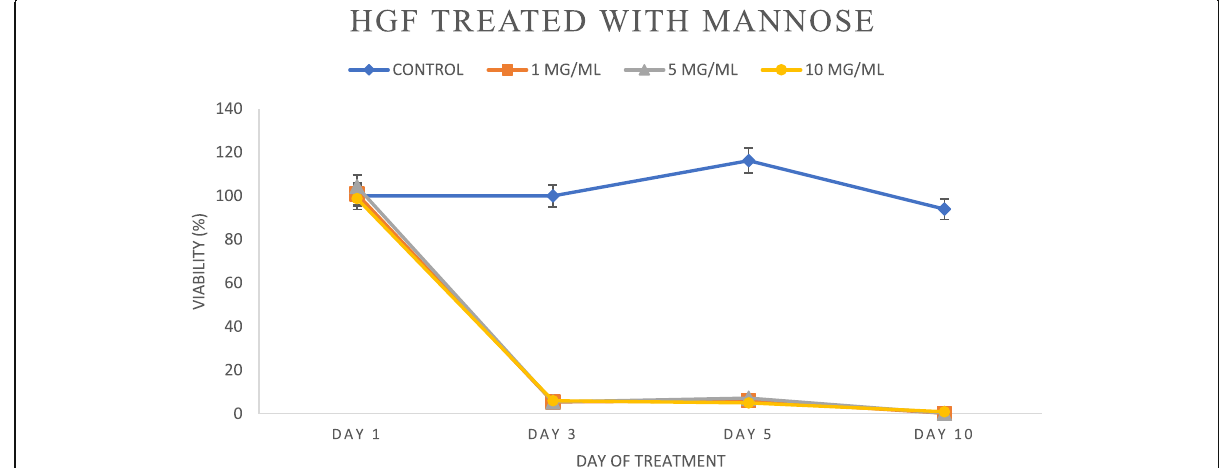
Fig. 1 The percentage of HGF cells when treated with mannose at 1 mg/ml, 5 mg/ml and 10 mg/ml for three period of times; day 1, day 3, day 5 and day 10 ( p value <